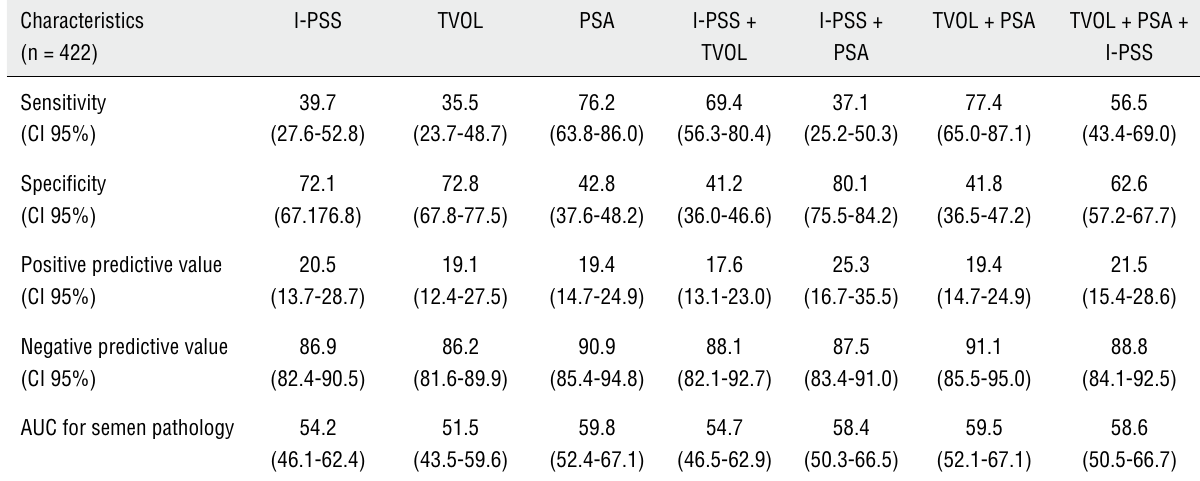
Table 3 - Areas under the ROC curve and diagnostic test characteristics (95% Cl) for total prostate volume, I-Pss score, serum PsA level and their combinations as characteristics used to estimate sperm pathology with cut-off levels of semen volume